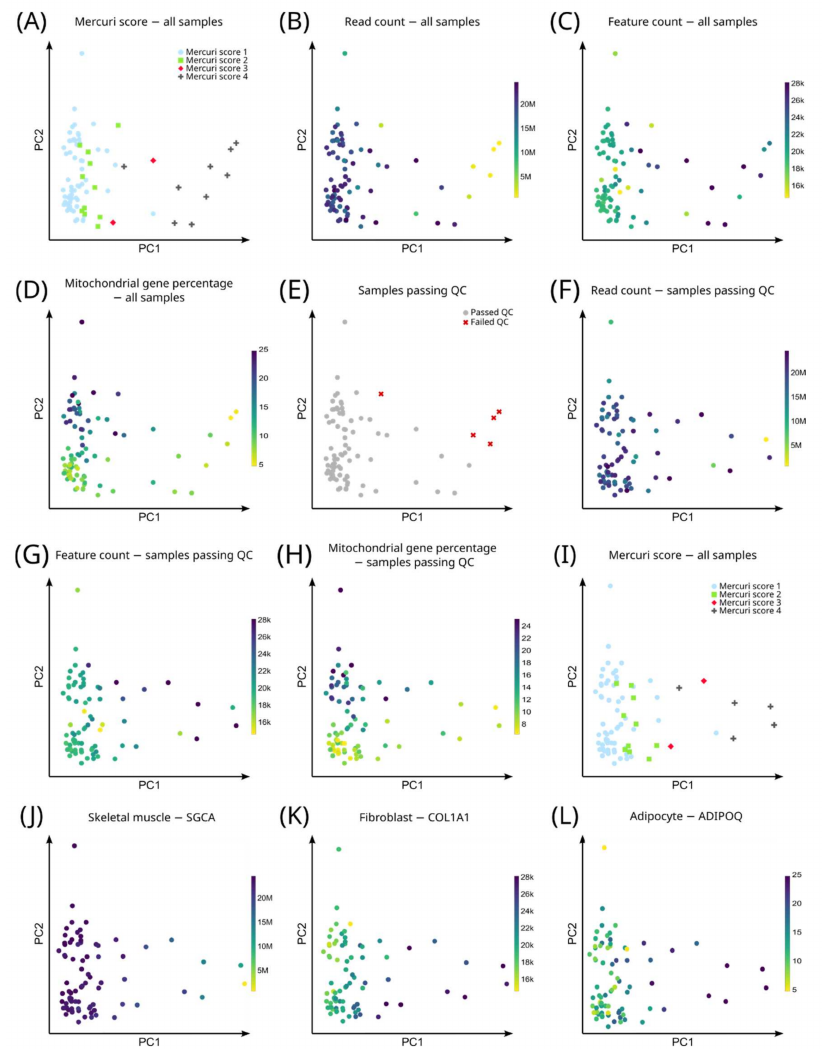
Figure 2. Unbiased transcriptome analysis of all genes. ( A ) PCA of all samples (n = 84), color coded for Mercuri score. ( B ) PCA of all samples (n = 84), color coded for read count. Note that samples with the highest Mercuri score had overall lower sequencing depth, which can be explained by the fact that the cellularity in high Mercuri score samples is lower due to replacement of muscle cells with fibrotic and adipose tissue. If there is low cellularity, then we also have lower transcripts and hence fewer reads that map to those transcripts. ( C ) PCA of all samples included in the study (n = 84), color coded for feature (gene) count. Note that samples with the highest Mercuri score had overall highest feature (gene) count. ( D ) PCA of all samples included in the study (n = 84), color coded for mitochondrial feature (gene) count. ( E ) PCA of all samples included in the study (n = 84), color coded for passing (grey, n = 79) or failing (red, n = 5) quality control (QC). All samples with 1M or more reads were considered to have passed QC. ( F ) PCA of samples that passed QC (n = 79), color coded for read count. ( G ) PCA of samples that passed QC (n = 79), color coded for feature (gene) count. ( H ) PCA of samples that passed QC (n = 79), color coded for mitochondrial feature (gene) count. ( I ) PCA of samples that passed QC (n = 79), color coded for Mercuri score. ( J ) PCA of samples that passed QC (n = 79), color coded for SGCA gene expression. Note, SGCA is a protein of the muscle membrane and SGCA gene expression (muscle membrane marker) was reduced in samples with higher Mercuri scores. ( K ) PCA of samples that passed QC (n = 79), color coded for COL1A1 gene expression (fibroblast marker). ( L ) PCA of samples that passed QC (n = 79), color coded for ADIPOQ gene expression (adipocyte marker). In the PCA plots each sample is represented by a dot. The dots are placed on the graph in function of their gene signatures, the closer the dots are together, the more similar their gene expression profile